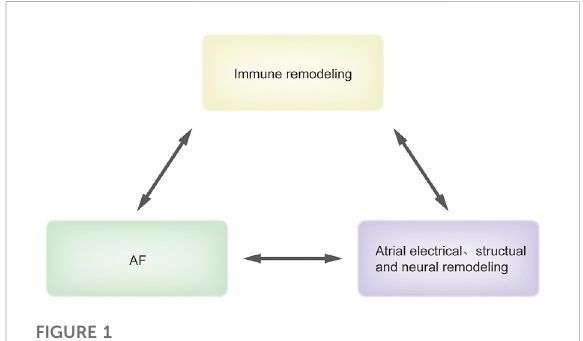
FIGURE 1 The association between immune remodeling and AF. This fi gure recapitulates brie fl y the association between immune remodeling and AF. Immune remodeling regulates atrial electrical, structual and neural remodeling to promote AF. In turn, AF- related pathologic changes including fi brosis can induce immune remodeling, which forms a positive circle loop. Abbreviations: AF, atrial fi